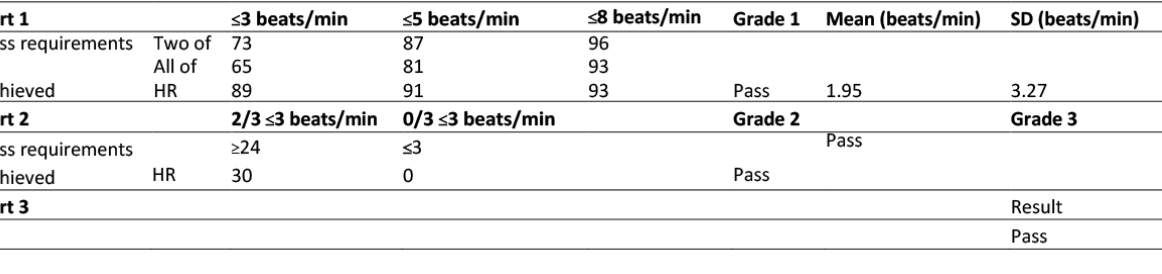
Figure 2. Validation results for the iHealth Track heart rate (HR) device according to European Society of Hypertension International Protocol revision 2010 (ESH-IP2). Accuracy is determined by the number differences in these ranges both for individual measurements (Part 1) and for individual subjects (Part 2). To pass, a device must achieve all the minimum pass requirements shown. Pass requirements are as required by the EHS-IP2; achieved are as recorded by the device.